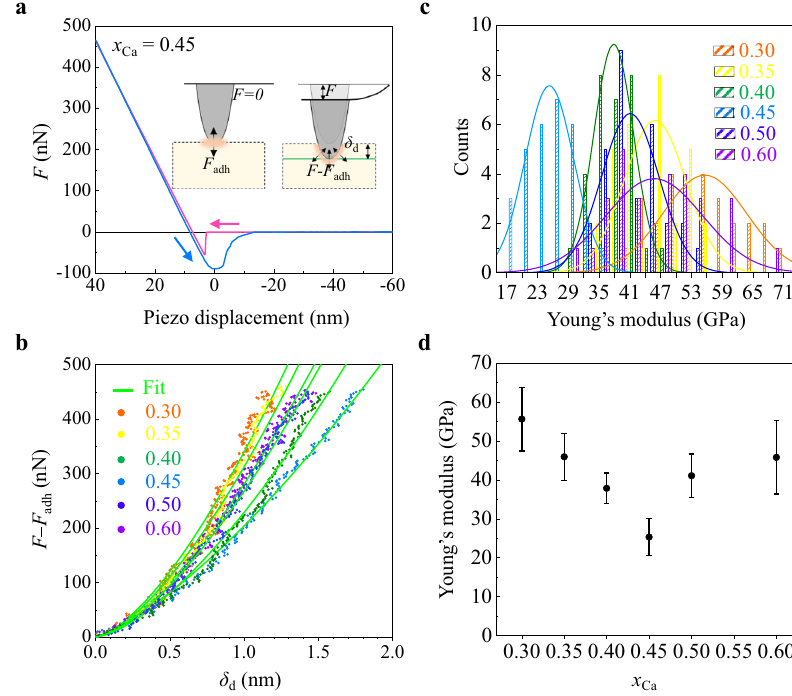
Fig.4|StructuralsoftnessinthecompositionalphasetransitionpointinBCFO andcyanindicateapproachandretreatmodes. b Tip-drivenforce( F − F adh )versus δ d fi lms. a Force versus distance curve of BCFO at x curves for selected x Ca . The DMT model was used to interpret these experimental Ca =0.45, obtained by character- izing the elastic property using an AFM technique. (Inset) The measured force ( F ) data,creatinggreen fi tlines. c StatisticsofthevaluesofYoung ’ smodulusobtained was evaluated by cantilever bending against surface depth deformation ( δ d ). Zero by repeating the force-distance measurement at many different places on the surface. The lines represent Gaussian fi ttings of the observed distributions. d The cantilever de fl ection, i.e., F =0, corresponds to the situation where the attractive measured Young ’ s modulus versus x Ca . The error bar is de fi ned as the standard adhesiveforce( F adh ≤ 0)betweenthesampleandtipisfullycompensatedbythetip pressingforce.So,therealtip-drivenforceonthesamplesurfaceis F − F adh .Magenta deviation of